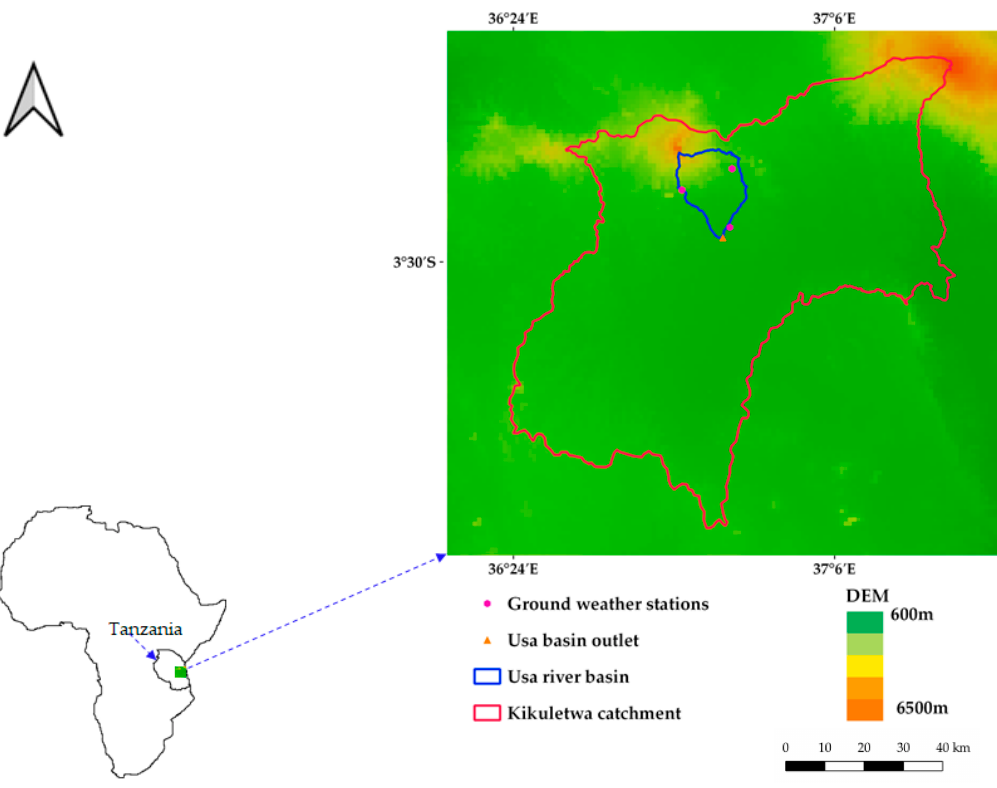
Figure 1. Location of Usa catchment within Kikuletwa river